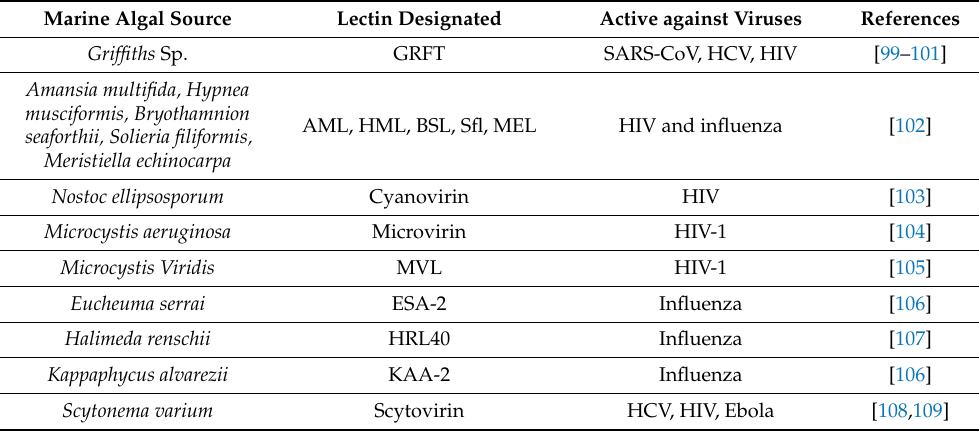
Table 2. Algae-derived antiviral pharmacologically active compounds and their targeted viruses. Marine Algal Source Lectin Designated Active against Viruses Griffiths Sp. GRFT SARS-CoV, HCV,